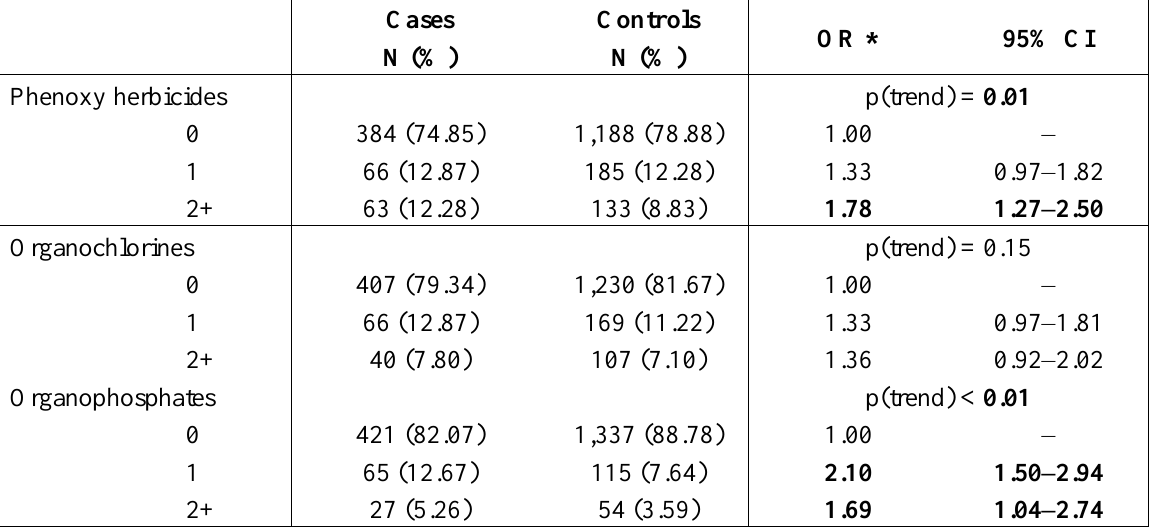
Table 3. Effect of exposure to multiple pesticides by selected classes on